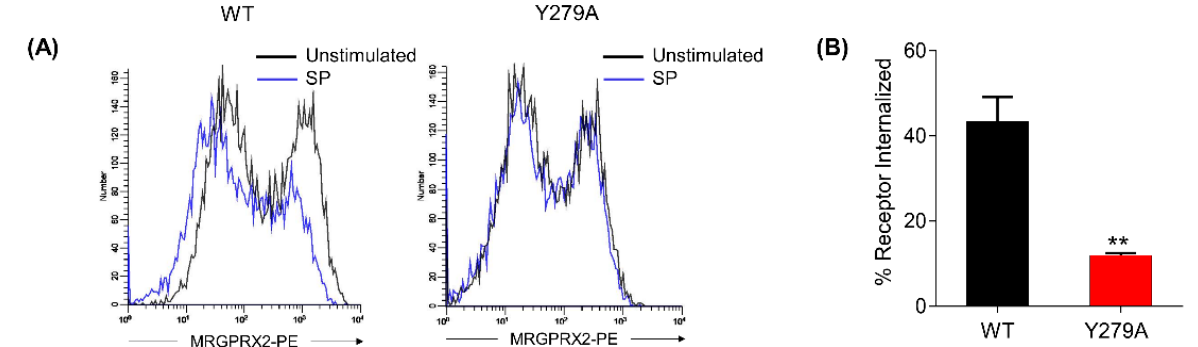
Figure 5. Y279A mutation of MRGPRX2 impairs SP-induced receptor internalization. ( A ) HTLA transiently expressing WT-MRGPRX2 or its Y279A mutant were stimulated with SP (30 µ M) for 30 min, and the receptor internalization was determined by flow cytometry. Representative histogram for cell surface receptor expression before (black line) and after SP stimulation (blue line) are shown. ( B ) The percentage of receptor internalization after SP stimulation was calculated. All data points are the mean ± SEM of at least three experiments. Two-tailed unpaired t -test was used. ** p < 0.001.